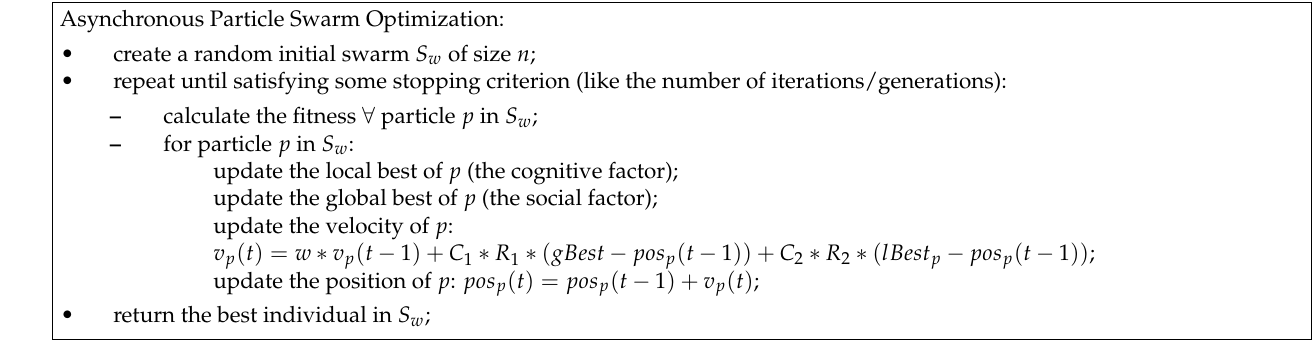
Figure 9. Procedural steps of